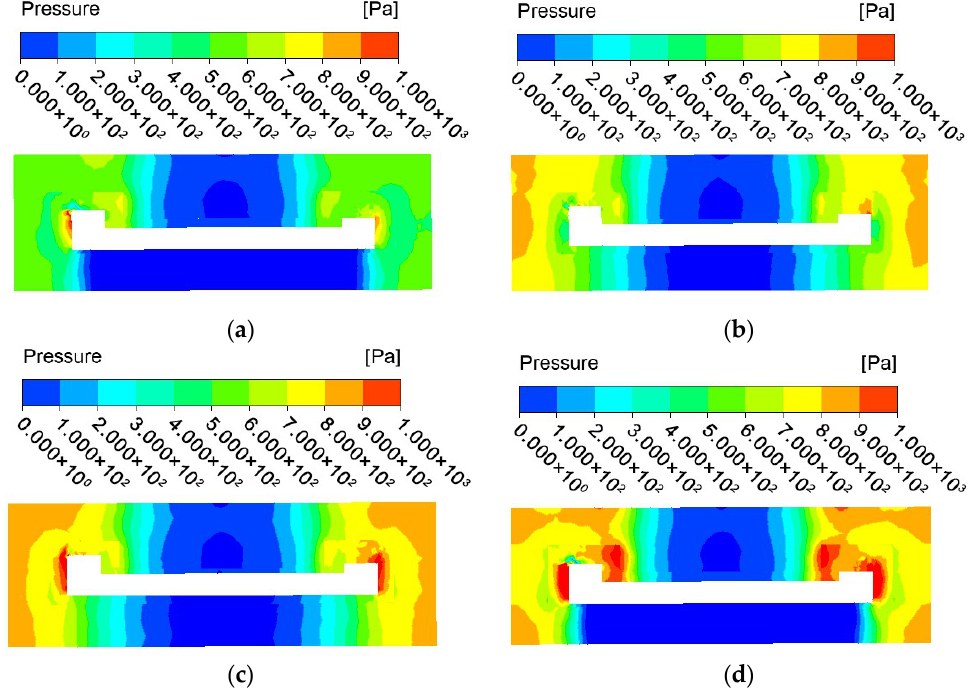
c : ( a ) 2.5 mm; ( b ) 5 mm; 2